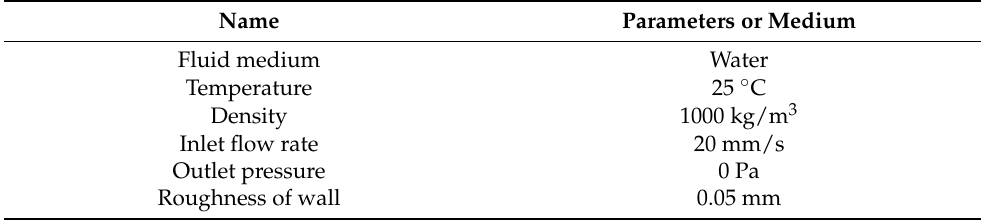
Table 1. The parameters of the physical